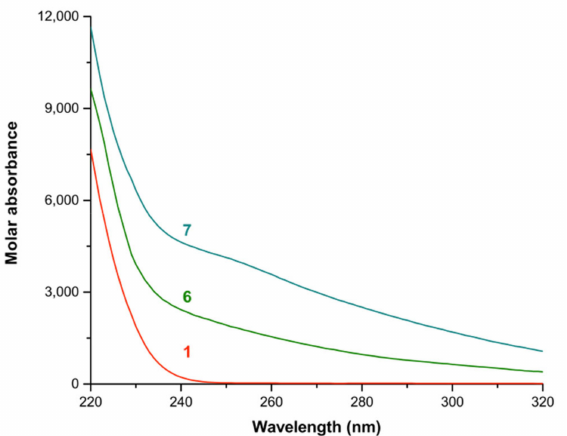
Figure 6. Calculated electronic spectrum of the manganese(II)–1,4-butanediamine species in methanol: (1) Mn 2+ ; (6) [Mn(bn)] 2+ ; (7) [Mn(bn) 2 ] 2+